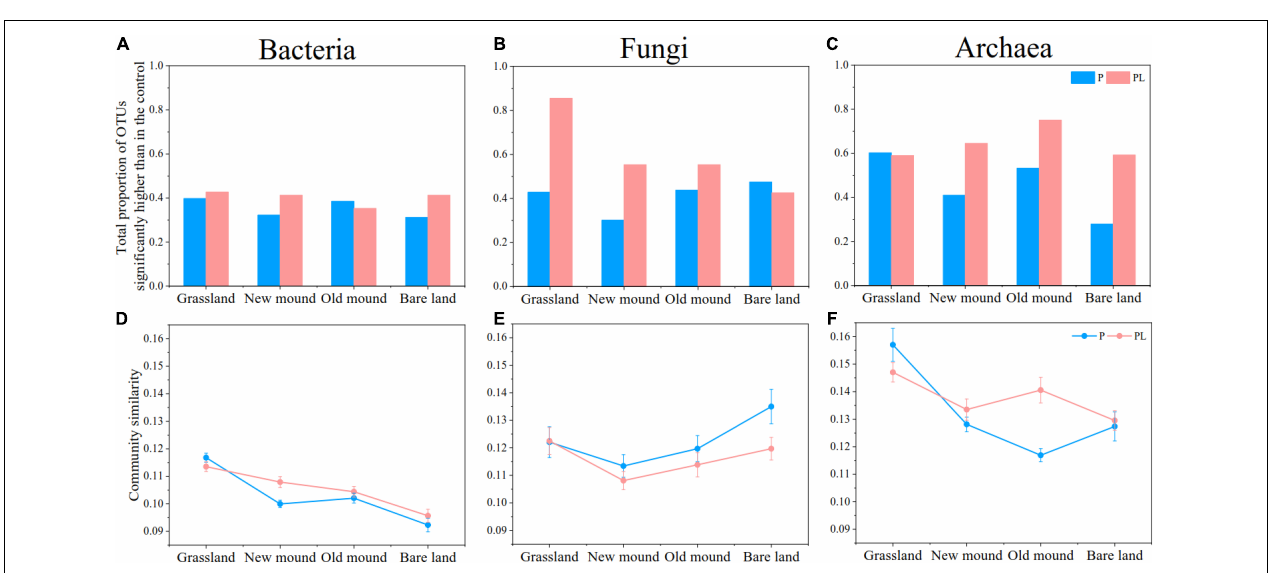
FIGURE 3 | The proportions of total bacterial (A) , fungal (B) , and archaeal (C) OTUs significantly enriched in each group compared with the natural grassland by Analysis of Variance (ANOVA) (all P < 0.05). The community similarity of bacterial (D) , fungal (E) , and archaeal (F) communities in each group based on Bray–Curtis distance metrics. P (blue), pika disturbance; PL (pink), grazing and pika disturbance.